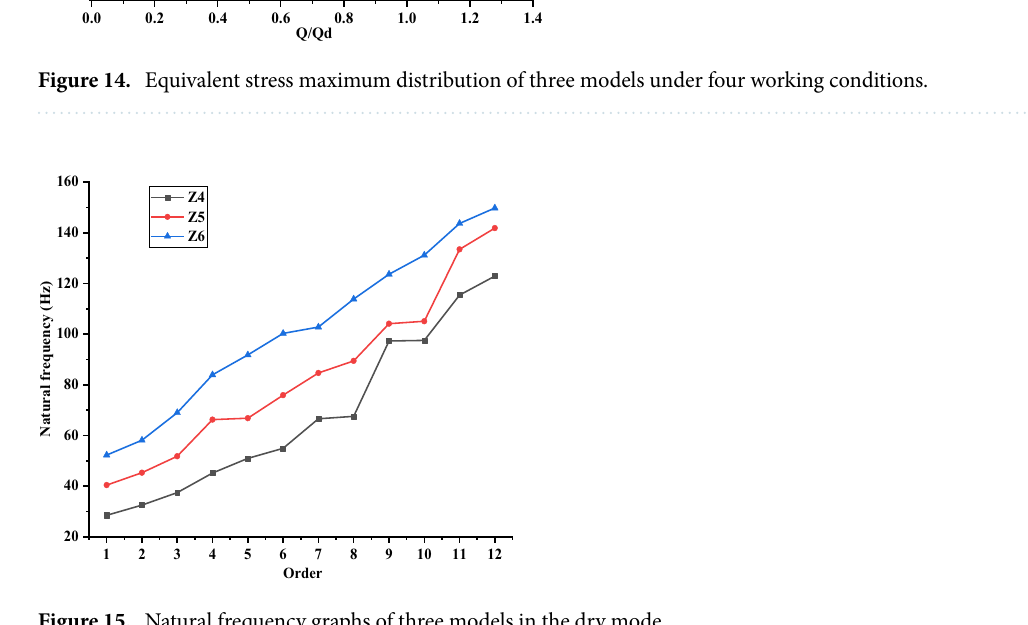
Figure 15. Natural frequency graphs of three models in the dry